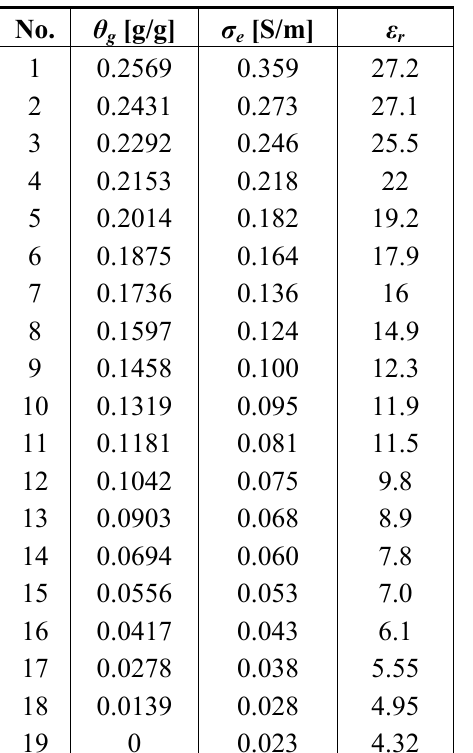
Table 2. Actual relative permittivity ε extracted from 19 measurements of the soil sample with different gravimetric water contents.